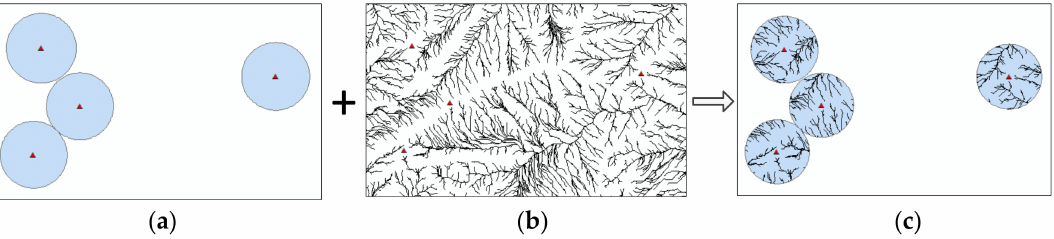
Figure 8. Clipping of the rivers. ( a ) Identification units and their centers. ( b ) Vector rivers in the experimental area. ( c ) Clipping result of rivers. The small triangles are the basin